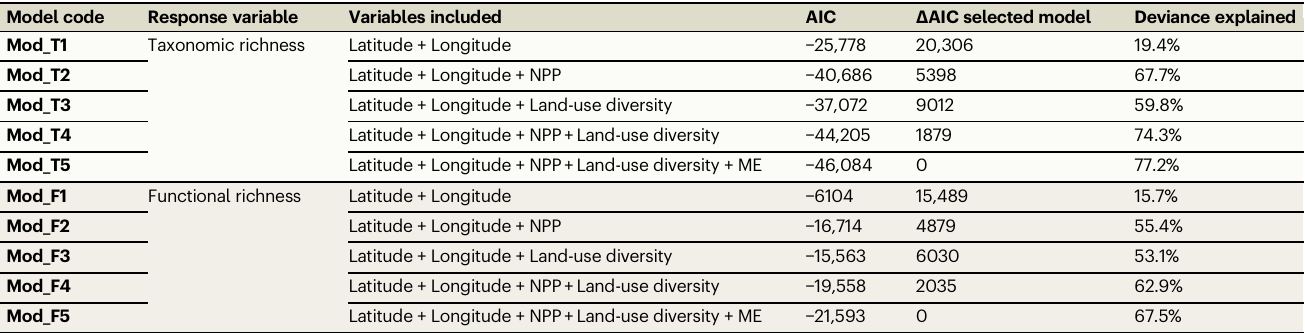
Table 1 | Competing models predicting global differences in bird taxonomic and functional richness Model code